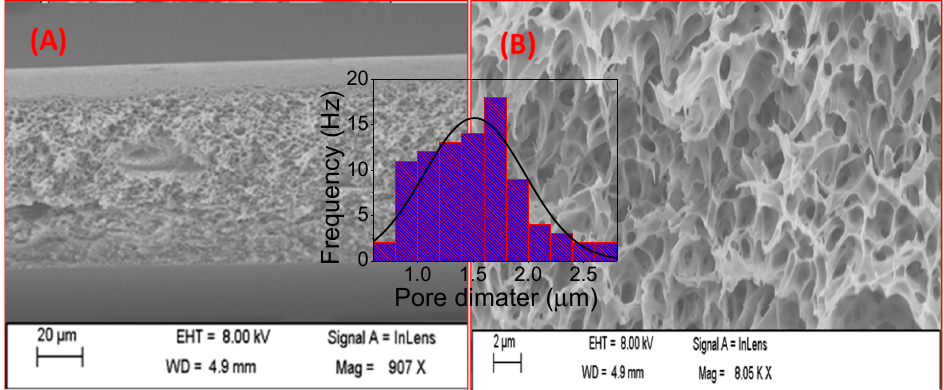
Figure 2. SEM images of pure PES membrane; ( A ) Cross-sectional view and ( B ) top view. The inset histogram showed the pore diameter distribution of the PES.